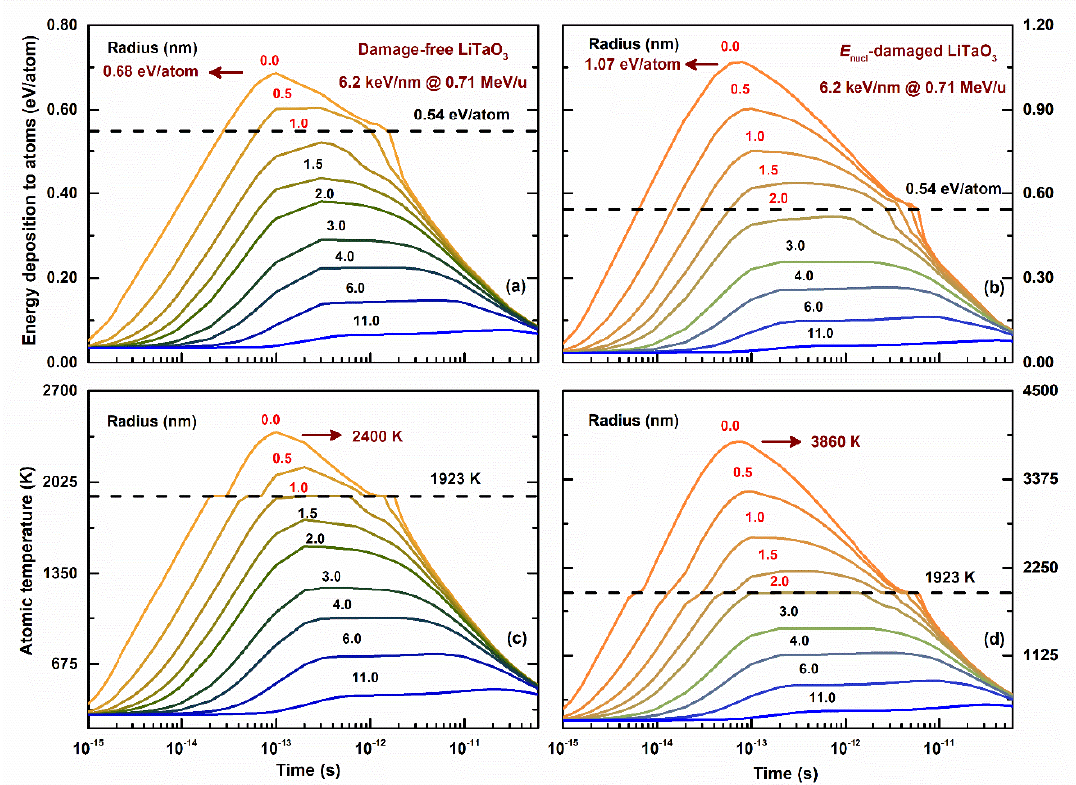
Figure 5. ( a , b ) Energy deposited to atoms and ( c , d ) corresponding evolution of atomic temperature at different radii versus time in damage-free and predamaged LiTaO 3 under subsequent electronic energy loss.